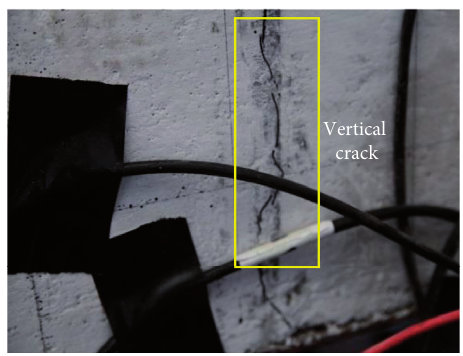
Figure 8: Vertical crack.